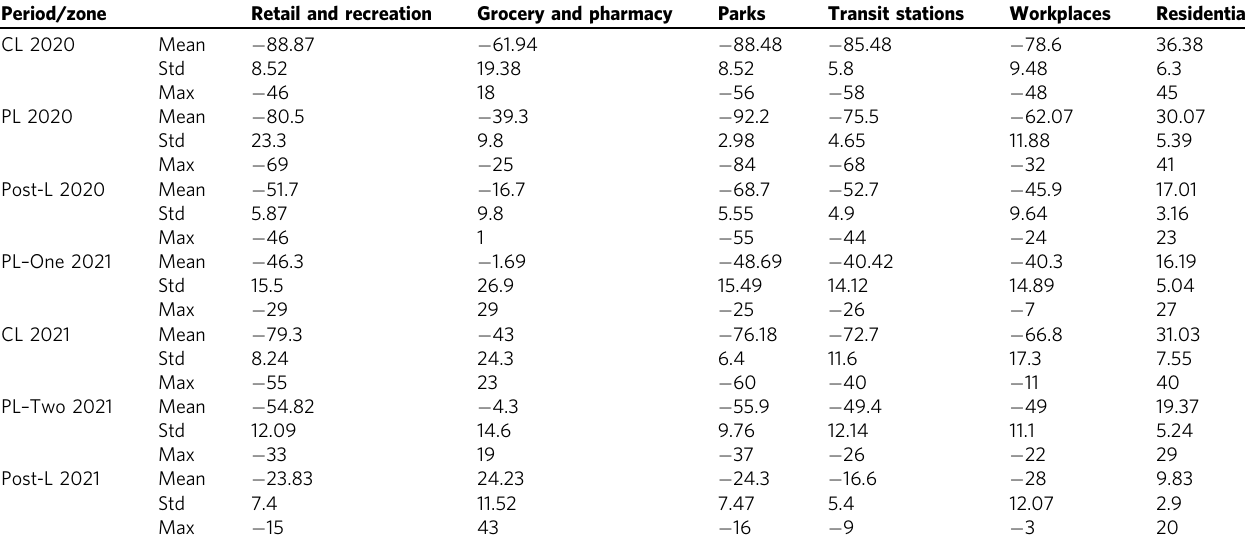
Table 3 Descriptive statistics of the changes in mobility (in %) from baseline during various lockdown phases in both waves in Chennai in the six spheres of